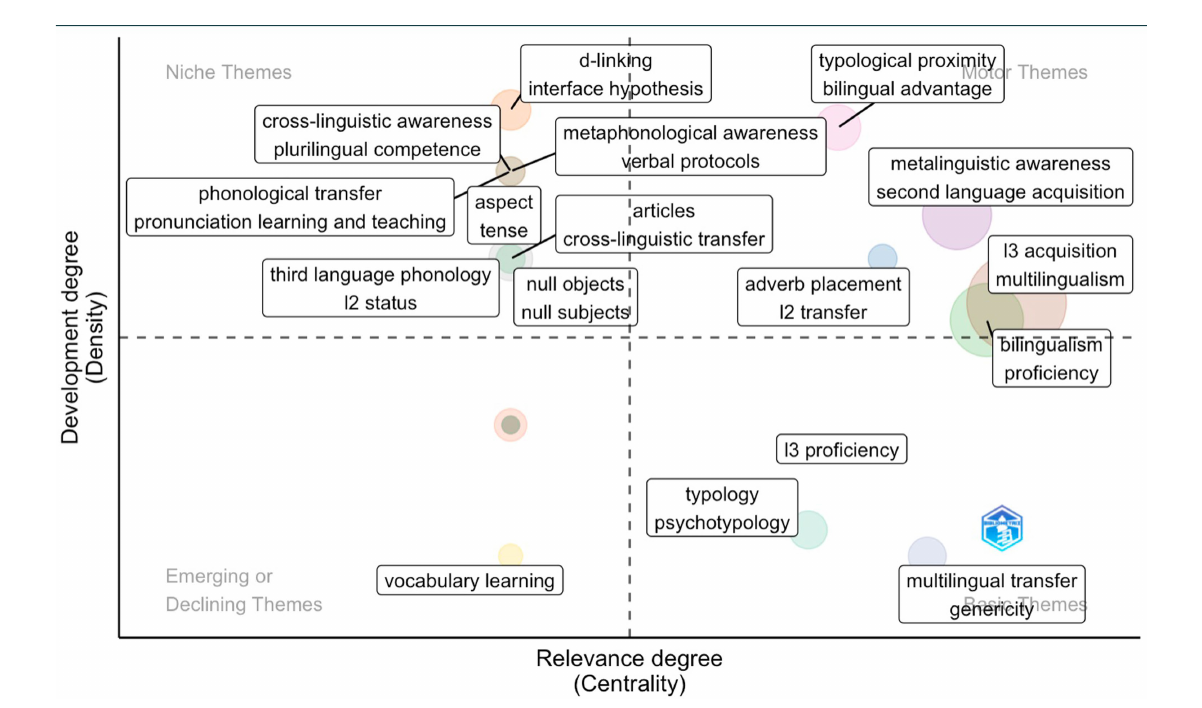
FIGURE 12 Thematic map showing clusters and the author’s keywords during the third period (2015–2022) identified by the co-occurrence